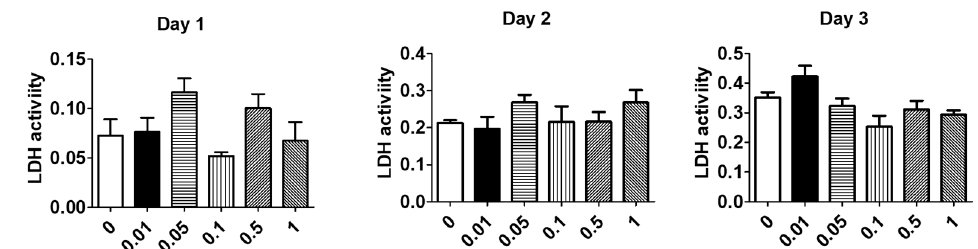
Figure 2. Effect of different doses of cucurbitacin-D (Cur-D) on cytotoxicity of U1 macrophages: U1-monocytes were plated in 12-well plates (0.3 million cells/well) and differentiated to macrophages. Differentiated U1 macrophages were treated with different doses of Cur-D ranging from 0.01 – 1 µM daily for 3 days. The Lactate Dehydrogenase (LDH) release in the supernatant was measured every day by the LDH assay.